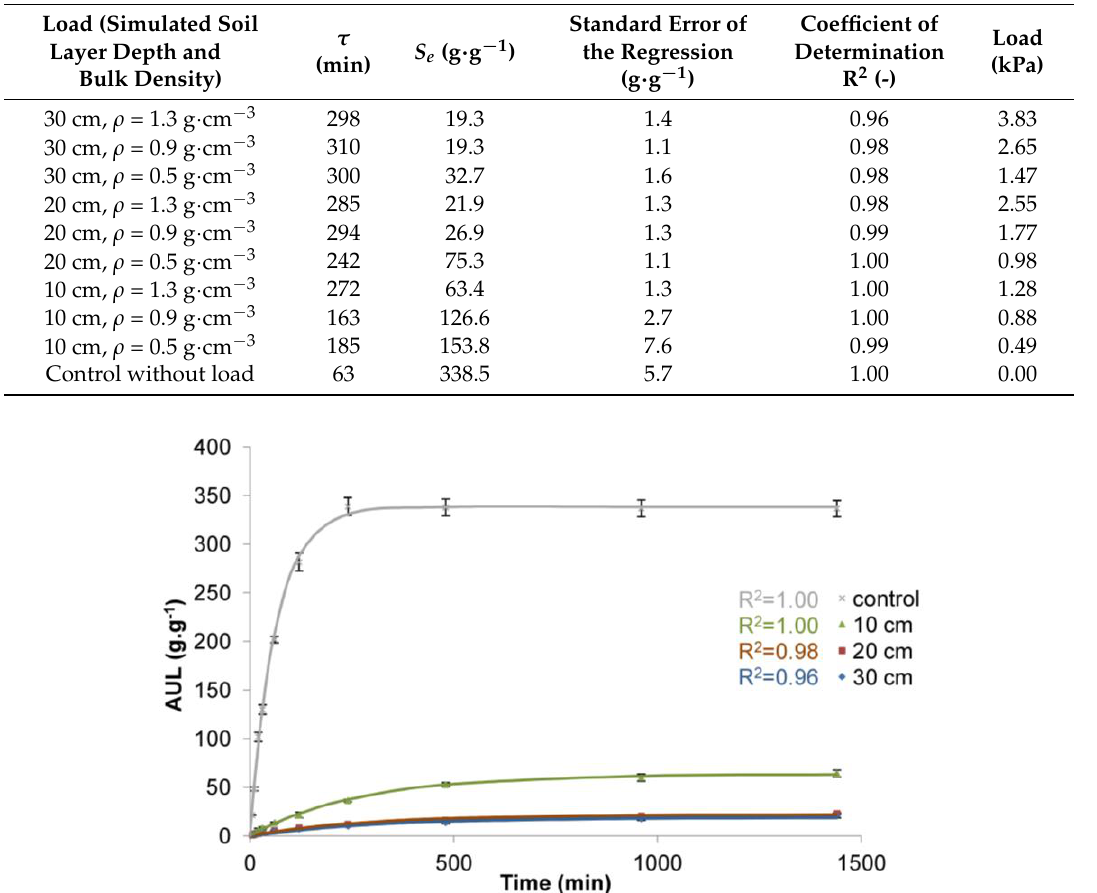
Figure 4. Time dependence of the AUL values for superabsorbent polymer loaded with soil of a bulk density of 1.3 g ∙ cm −3 and 10, 20, and 30 cm deep soil layers.